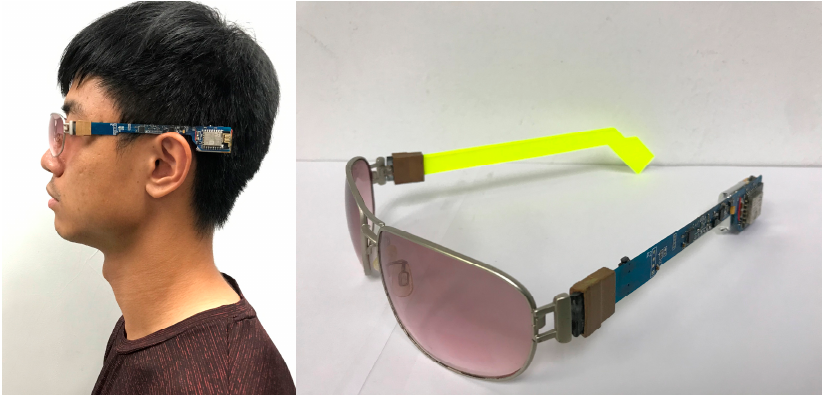
Figure 5. Photograph of prototype device.